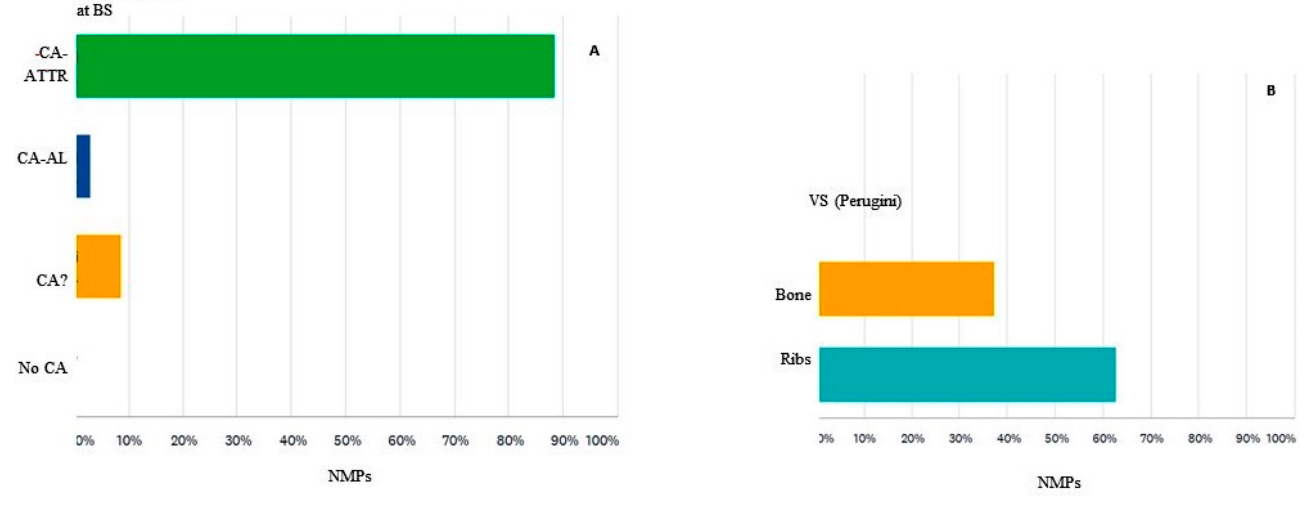
Figure 5. ( A ) Interpretation of survey participants of scintigraphy in which bisphosphonates accumulate in the myocardium. CA-ATTR = cardiac amyloidosis with transthyretin, CA-AL = cardiac amyloidosis with light chains, CA? = cardiac amyloidosis of uncertain nature, No CA = the appearance is not related to cardiac amyloidosis, M = myocardium, BS = bone scan. ( B ) Semi-quantitative analysis score (Perugini) of cardiac uptake of 99mTc-bisphosphonate compared to uptake of the ribs, VS = visual score, Bone = VS related to bone, Ribs = VS related to ribs, NMPs = nuclear medicine physician, BS = bone scan.